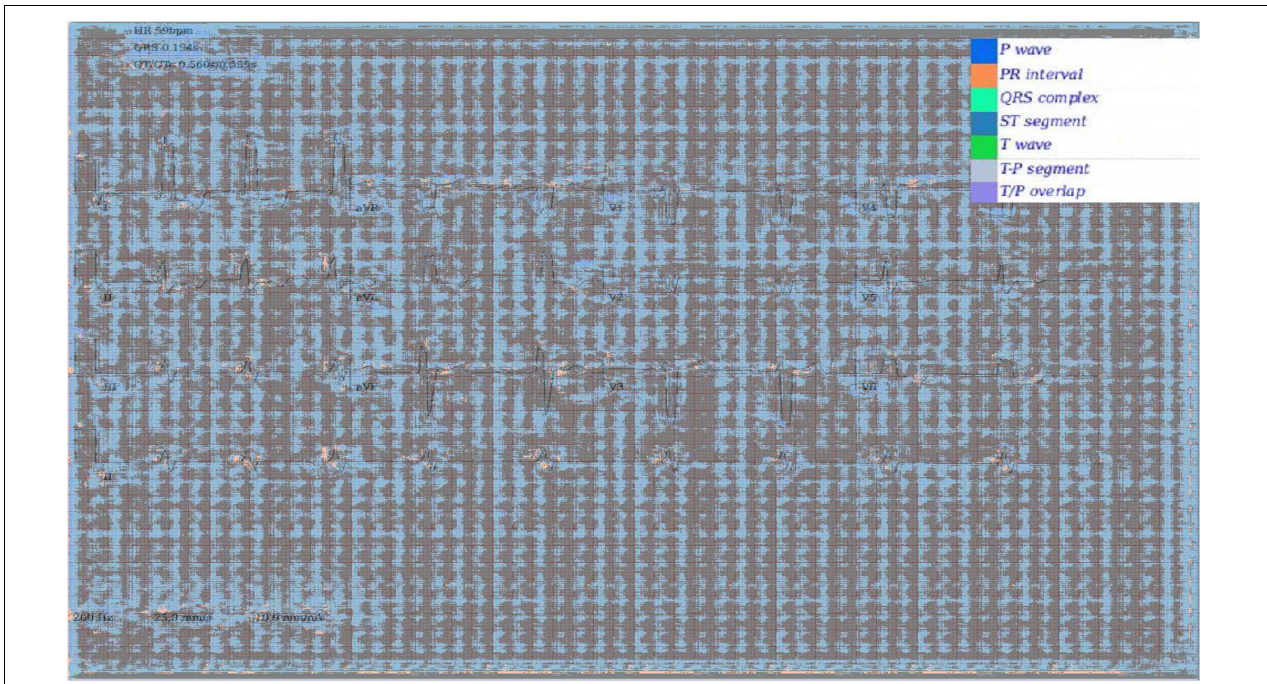
FIGURE 8 | Segmentation mask produced by a 2D model initiated with ImageNet weights, but not having undergone any further training on ECG segmentation nor classification